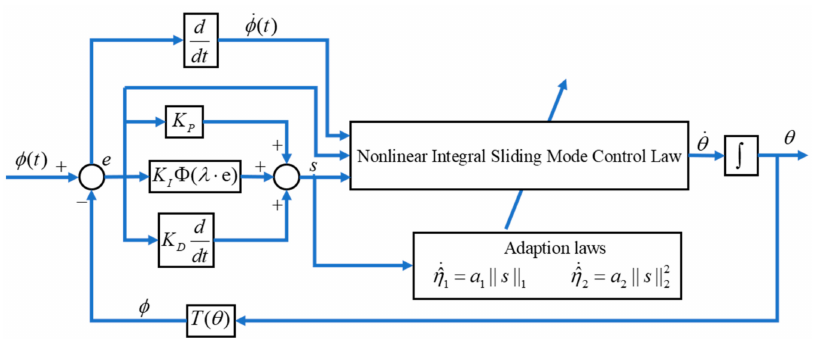
Figure 7. The block diagram of the nonlinear integral sliding mode